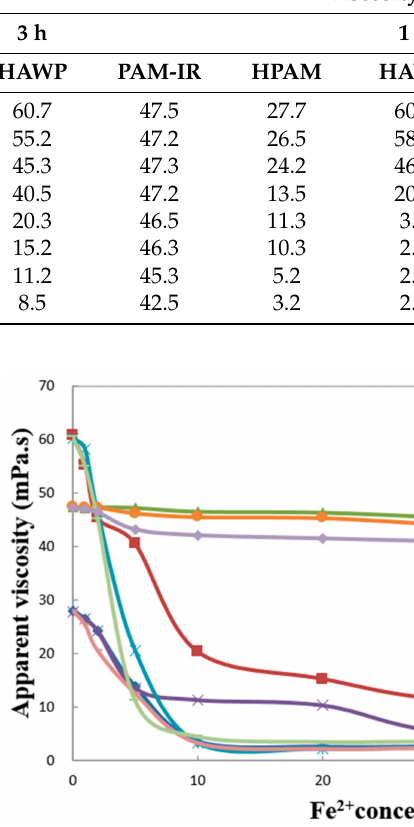
Figure 4. Fe 2+ concentration versus apparent viscosity of the polymer